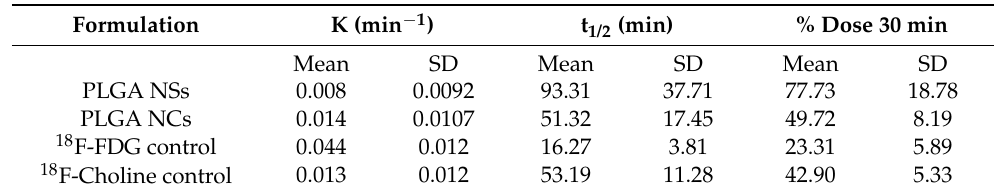
Table 3. Ocular biopermanence parameters for 18 F-Choline radiolabeled PLGA-based nanoparticles and 18 F-FDG control (named as “control” in the table) formulations.